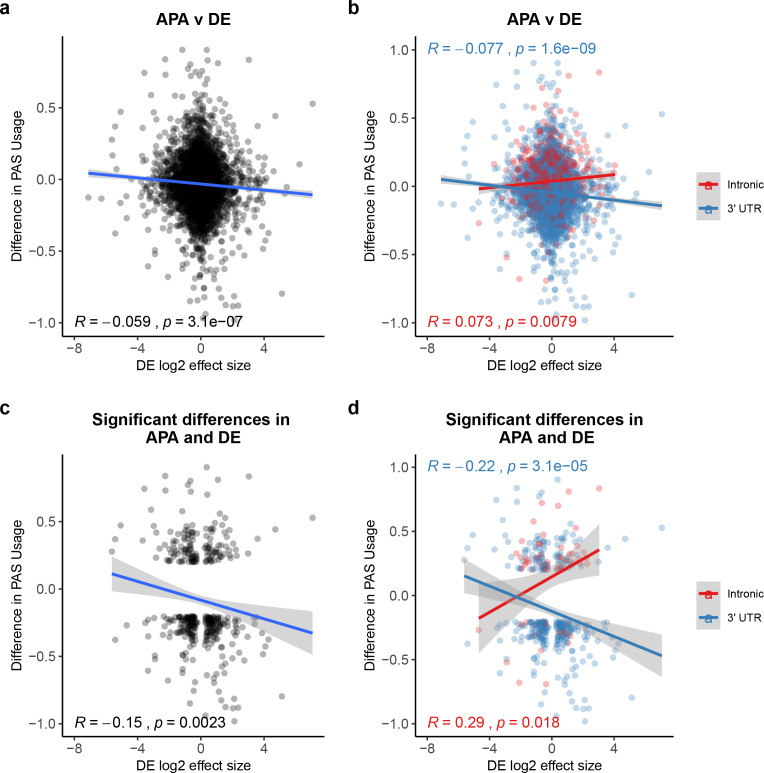
Polyadenylation sites (PAS) usage differences for intronic and 3' UTR PAS correlate with differential (DE) effect sizes at similar magnitudes but in opposite directions.(a) Changes in polyadenylation site usage (ΔPAU) for top intronic or 3' UTR PAS per gene (see 'Materials and methods') plotted against DE effect size from differential expression analysis. Pearson’s correlation plotted, Spearman’s correlation R = −0.053. (b) ΔPAU for top intronic or 3' UTR PAS per gene (see 'Materials and methods') plotted against DE effect size from differential expression analysis for genes with significant differences in each phenotype at 5% FDR. Pearson’s correlation plotted, Spearman’s correlation intronic R = 0.046, Spearman’s correlation 3' UTR R = −0.054. (c) ΔPAU for top intronic or 3' UTR PAS per gene (see 'Materials and methods') plotted against DE effect size from differential expression analysis. Pearson’s correlation plotted, Spearman’s correlation R = −0.16. (d) ΔPAU for top intronic or 3' UTR PAS per gene (see 'Materials and methods') plotted against DE effect size from differential expression analysis for genes with significant differences in each phenotype at 5% FDR. Pearson’s correlation plotted, Spearman’s correlation intronic R = 0.22, Spearman’s correlation 3' UTR R = −0.22. In all panels, we calculated the linear regression. In all panels, negative ΔPAU and DE effect sizes represent upregulation in chimpanzees. In panels b and d, we colored the points and regressions by genic location.